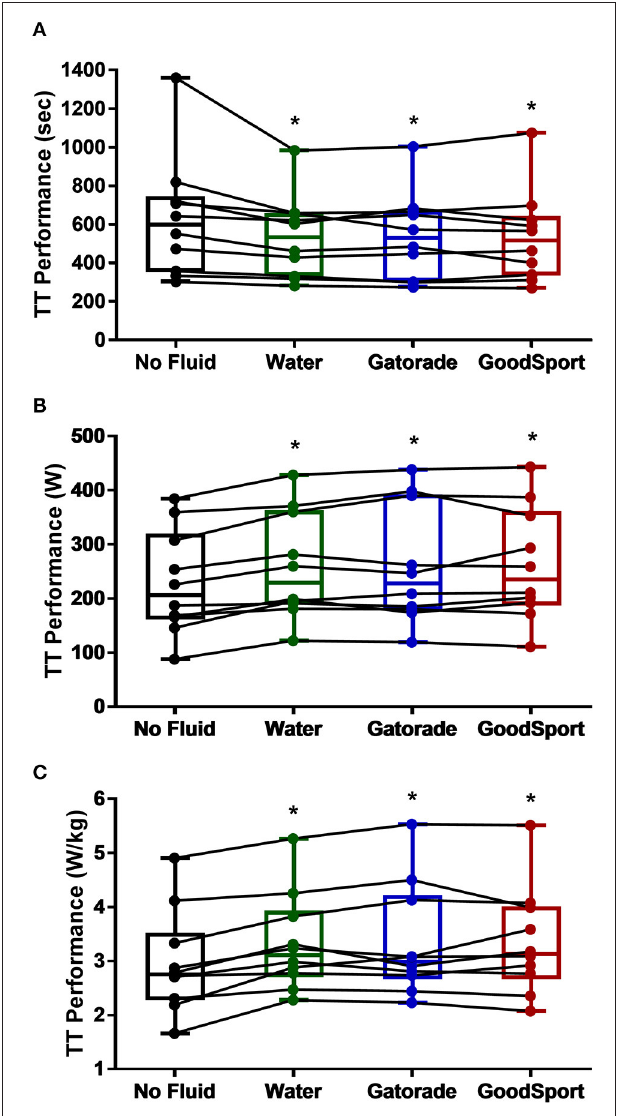
FIGURE 4 | 120 kJ time-trial performance in hot dry condition, measured as (A) time (s), (B) absolute power (W), and (C) relative power (W/kg). All three measures of time-trial performance were improved in the three beverage trials compared to no fluid. Boxes represent first and third quartiles with median values denoted by the horizontal line, while whiskers indicate minimum and maximum observations. Dots represent data points for each subject, and lines indicate changes in performance between trials for each subject. * p < 0.05 vs. no